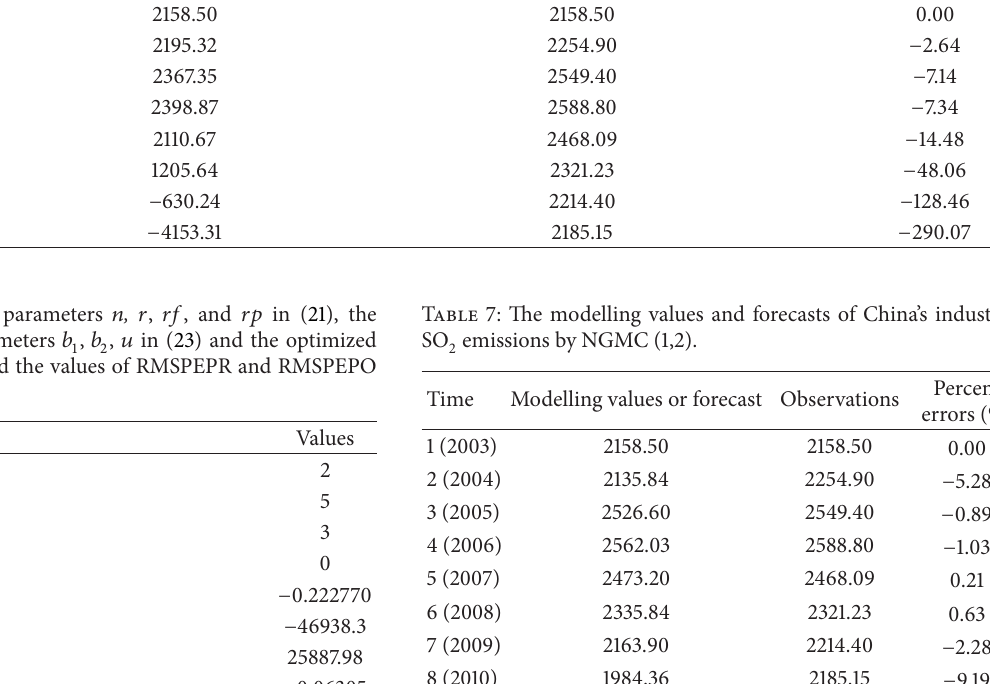
Table 4: The modelling values and forecasts of China’s industrial SO